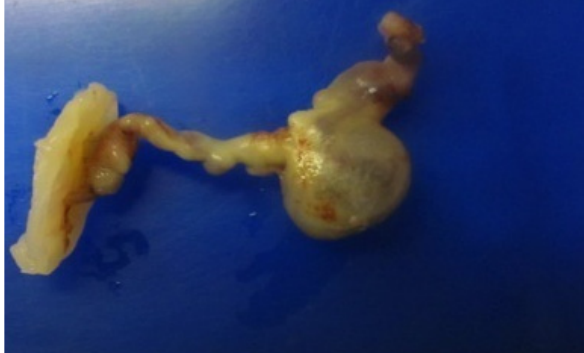
Figure 2. Gross Pathology. Left anterior thoracotomy, pericardial window and left anterior mediastinotomy were done, revealing a well-encapsulated gelatinous tumor originating from the pericardium (5.2 × 1.3 × 0.7 cm).